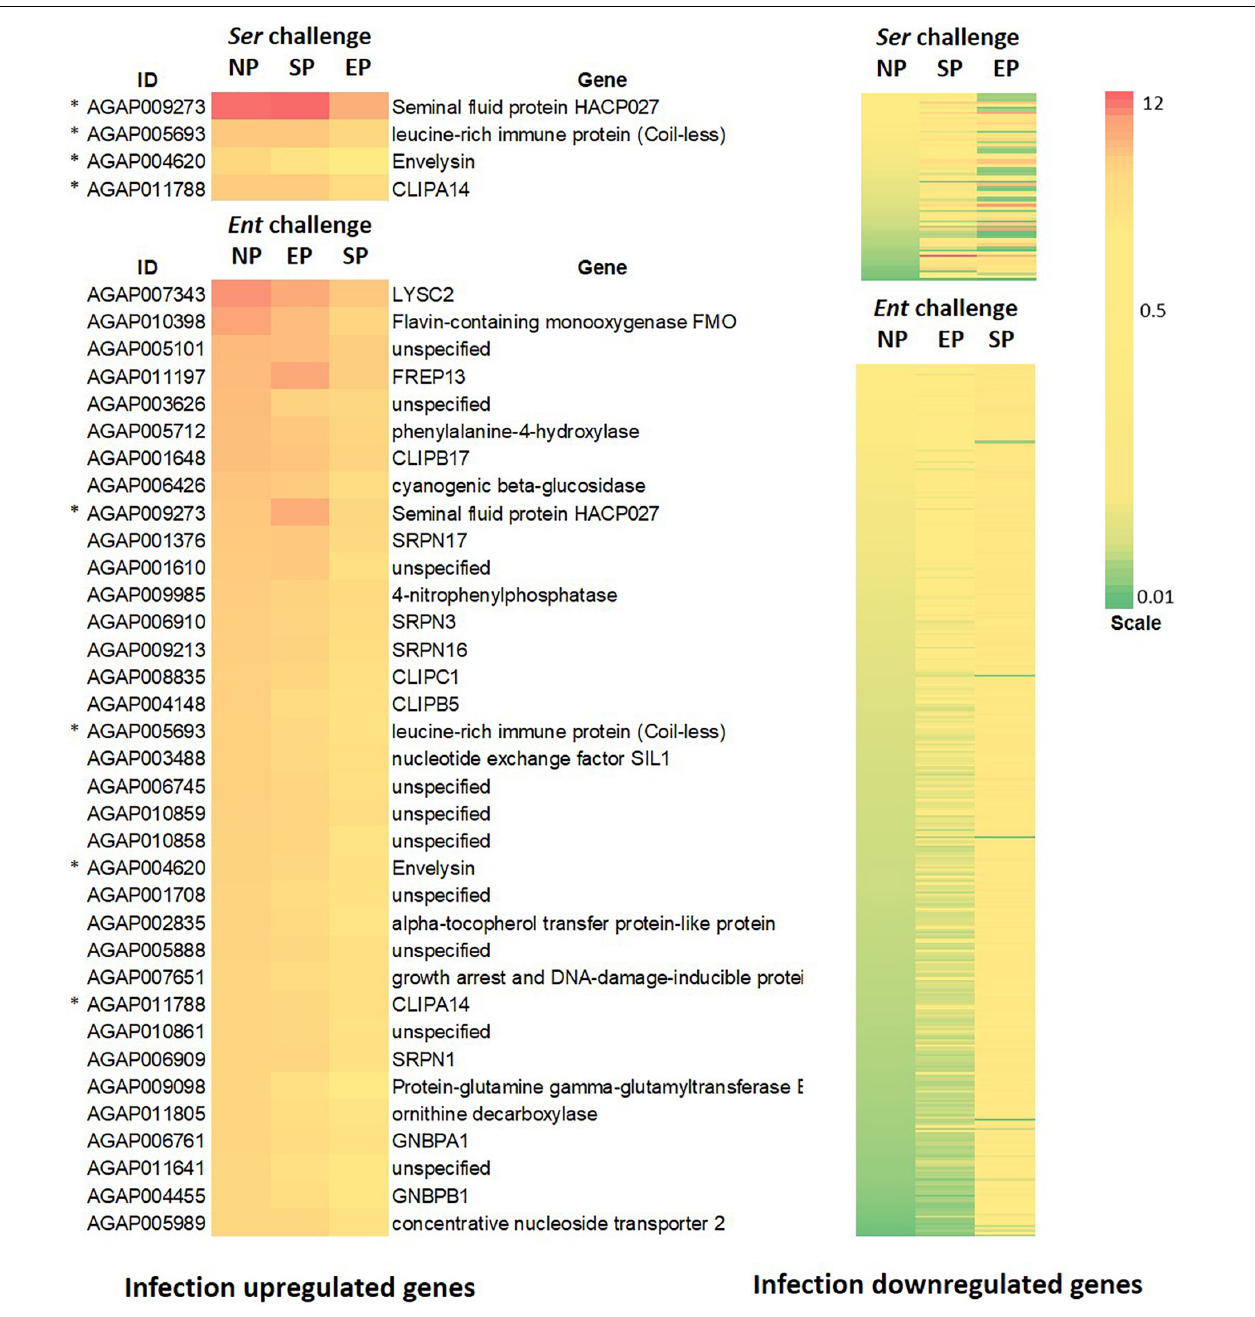
FIGURE 8 | Impact of prior homogeneous and heterogeneous priming on the infection responsive genes. In the Serratia challenged cohorts, the infection induced genes ( > 2-fold) were downregulated by the Enterobacter priming, while the infection repressed genes ( < 2-fold) were either increased or further decreased. In the Enterobacter challenged cohorts, the Enterobacter infection induced genes were downregulated by the Serratia priming, however, most of infection repressed genes were upregulated by the Serratia priming. * marks genes that were affected by both challenges. The gene ID and annotation in the downregulated panel were provided in Supplementary Table 5 . The heatmaps represent genes with significant difference between the NP and homogeneous and heterogeneous priming ( q -value < 0.05).